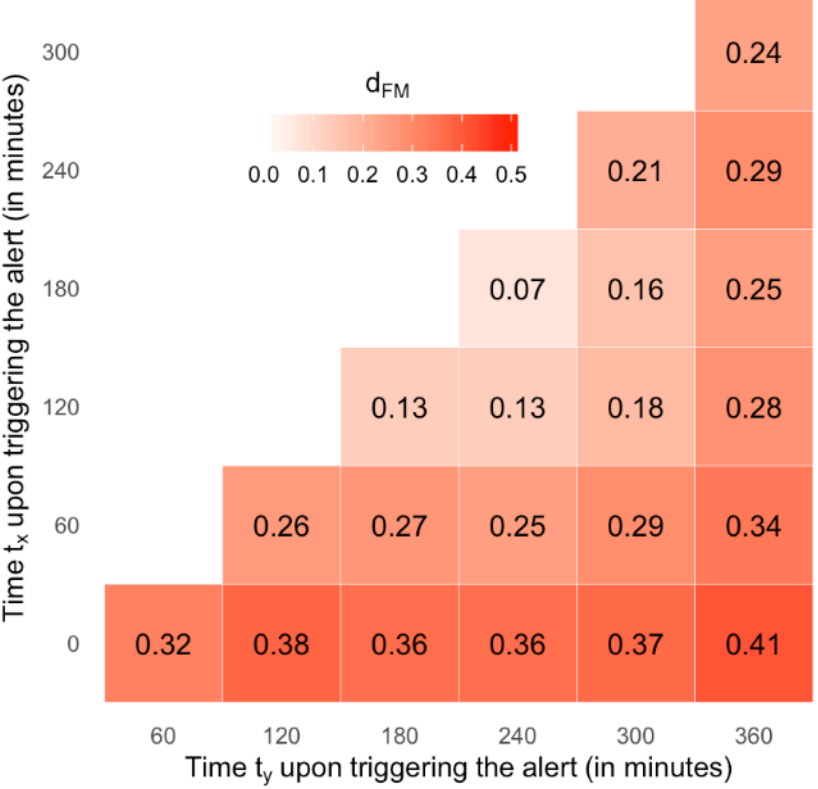
Figure 5. An overview of standardised differences ( d FM ) used for analysing the effect size that the gender covariate has estimated the conditional defect free survival probabilities CDFS t x = 0 denotes baseline time, i.e., the time of alert generation.